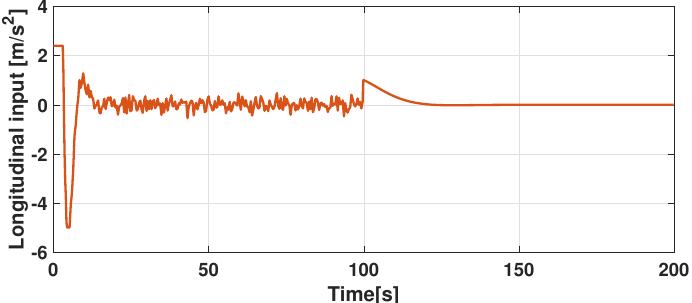
Figure 10. Single lane change scenario . Performance of the proposed solution. Time-history of the ego vehicle longitudinal input u 2 ( t )